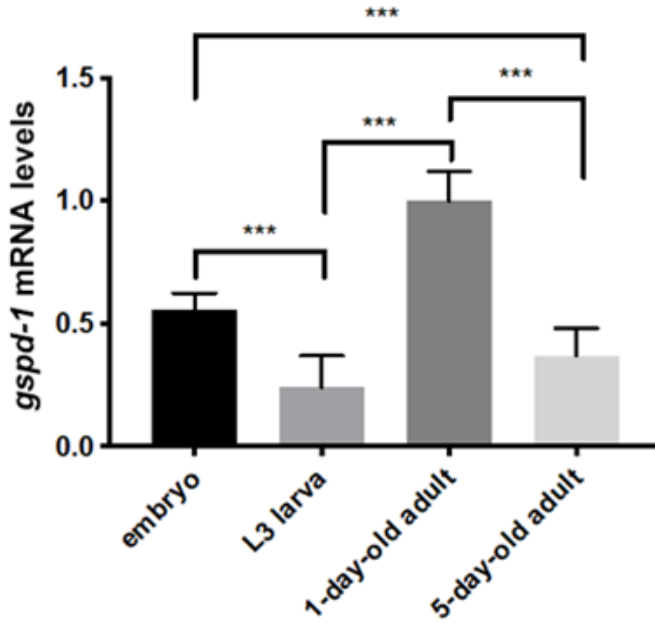
Figure 1. Gene expression pattern of gspd-1 during development by qPCR. The mRNA expression level of gspd-1 in the four C. elegans stages was analyzed by quantitative PCR. The results are presented as the relative expression level and normalized by act-1 . Fold change data from three independent experiments are shown as the mean ± SD ( n = 3, *** p < 0.001).